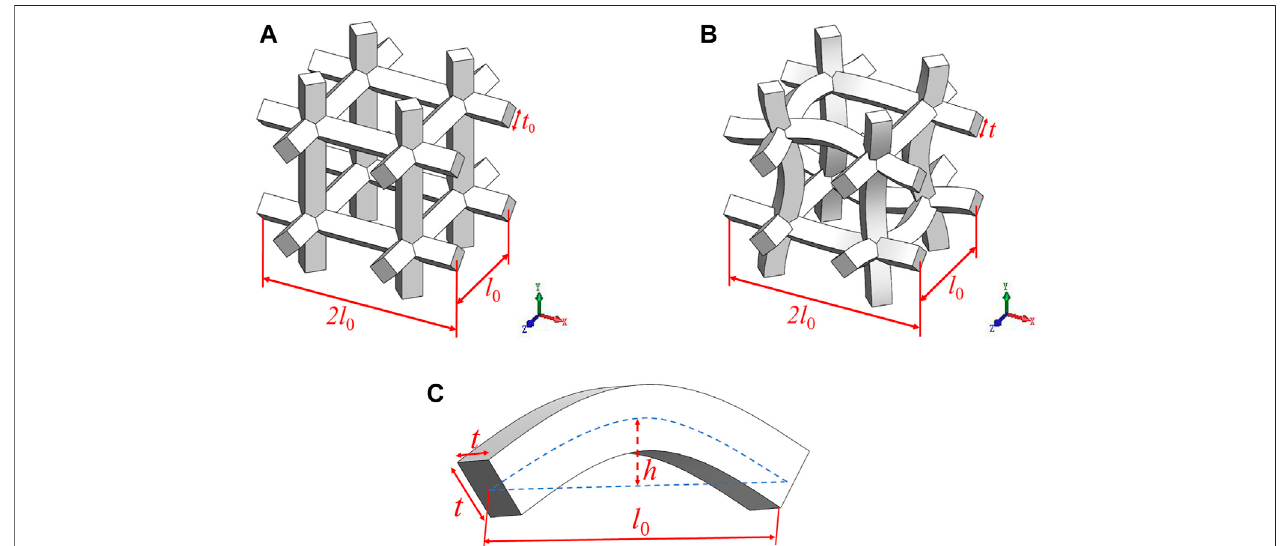
FIGURE1|(A) Cubic unitcellmodeloftheconventionalopen-cell foams,inwhichtheedgethicknessis t 0 andtheedgelengthis l 0 ; (B) Cubicunitcellmodelofthe negative Poisson ’ s ratio convex-concave foams; (C) Schematic diagram of the sine-shaped cell edges of the convex-concave foams (CCF) with chord span l 0 , chord height h , and thickness t